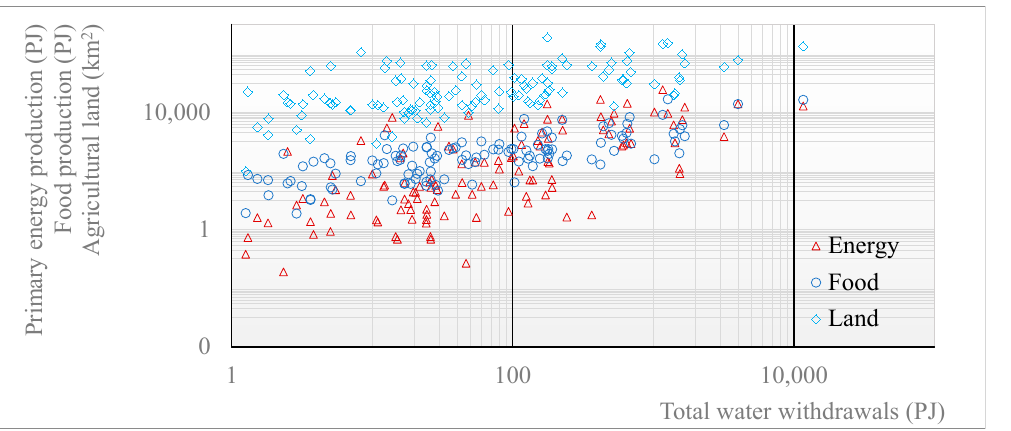
Figure 6. Primary energy production, food production, and agricultural land vs. total water with- drawals expressed in energy units as desalinated water (2019).